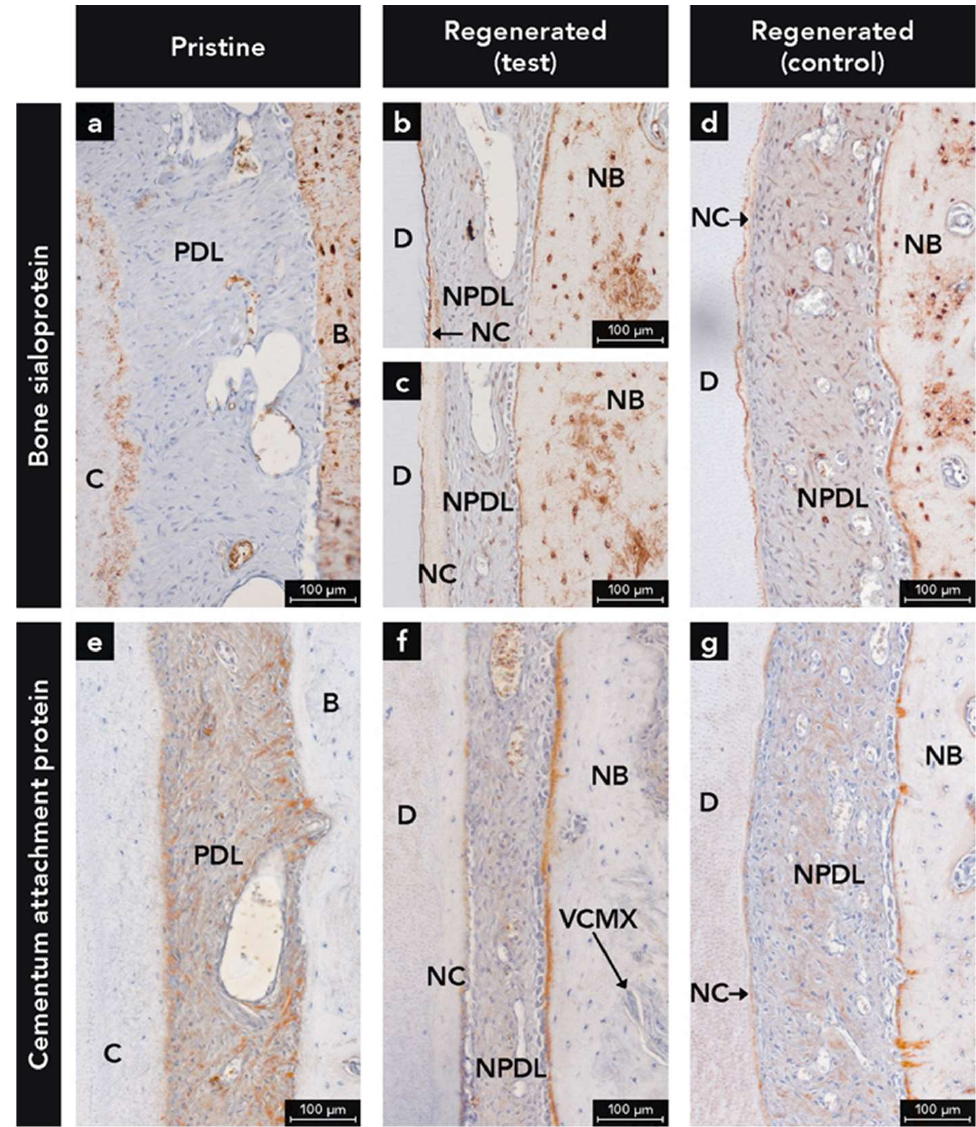
Figure 4. Micrographs demonstrating immunohistochemical staining for ( a , b , c , d ) bone sialoprotein antibody and ( e , f , g ) cementum attachment protein; ( f ) Integration of residues of the volume stable collagen matrix (VCMX) in new bone (NB); Counterstaining: Mayer’s hematoxylin solution; B, bone; C, cementum; D, dentin; NC, new cementum; NPDL, new periodontal ligament; PDL, periodontal ligament.